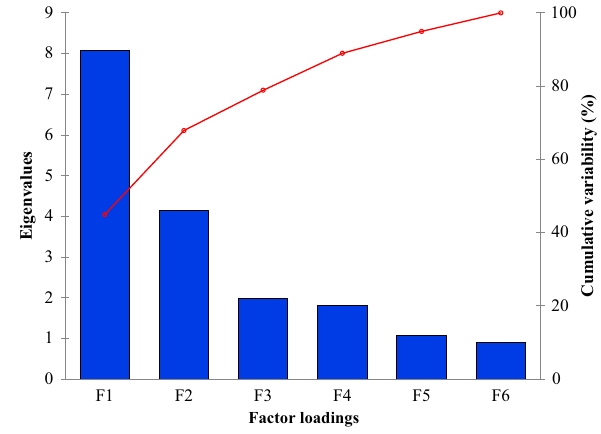
Fig. 5 Scree plot of the eigenvalues